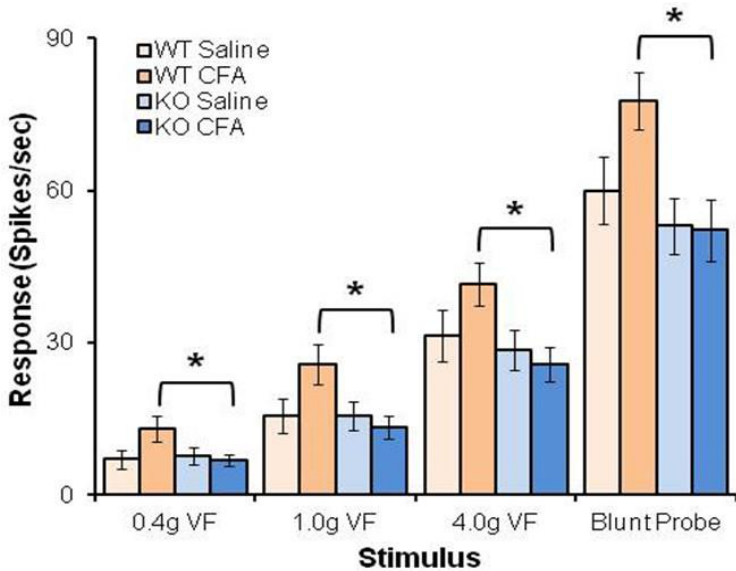
Figure 2. TrkB.T1 deletion decreases wide dynamic range neuron hyperexcitability after inflammation. Complete Freund’s Adjuvant (CFA, 20 µ L) or saline was injected subcutaneously into the plantar surface of the left hind paw in both TrkB.T1 WT and knockout (KO) mice. After 24 h, wide dynamic range neurons (WDRNs, the number of spikes per second) were recorded in the lumbar enlargement spinal dorsal horn (SDH) ipsilateral to the inflammation. In response to stimulation of von frey filament (VF) and blunt probe, there was significantly less neuronal hyperexcitability of neurons from inflamed KO mice compared to WT. There was no di ff erence between saline-treated WT and KO mice ( n = 15 per group). * p < 0.05 WT CFA vs KO CFA with two-way analysis of variance (ANOVA), following Tukey’s multiple comparisons test.